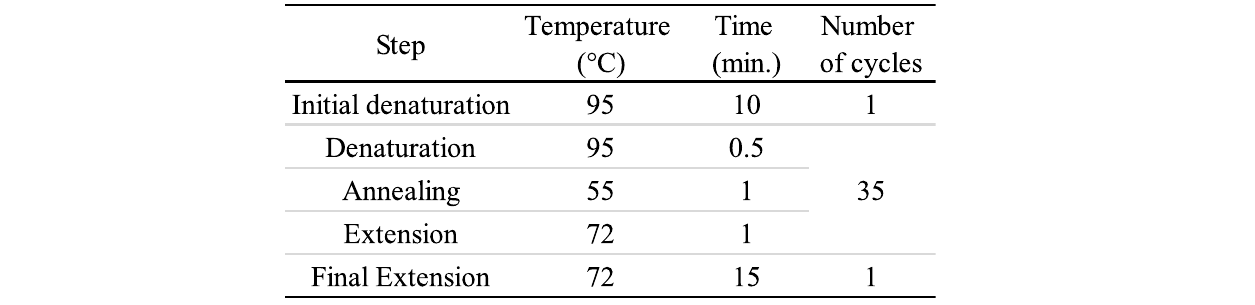
Table 1 PCR conditions used in this